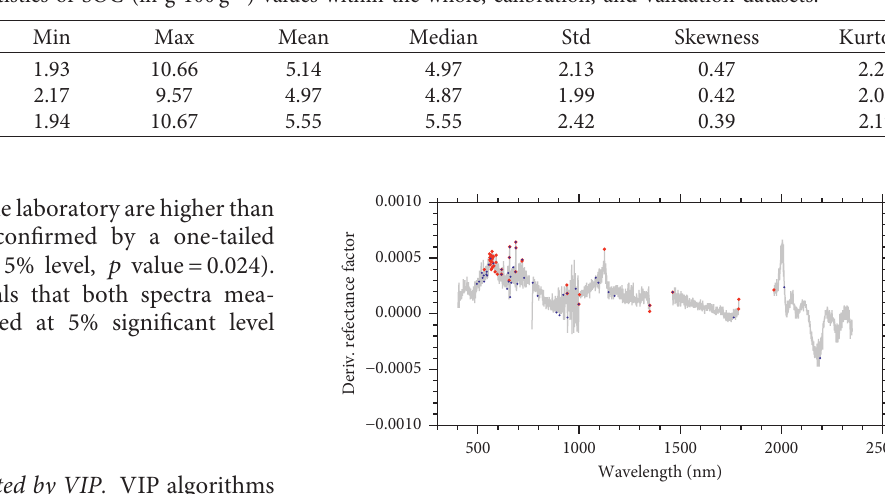
Figure 4: Field spectra first derivative and location of key wave- length selected by VIP (red dots) and RF recursive feature selection (blue